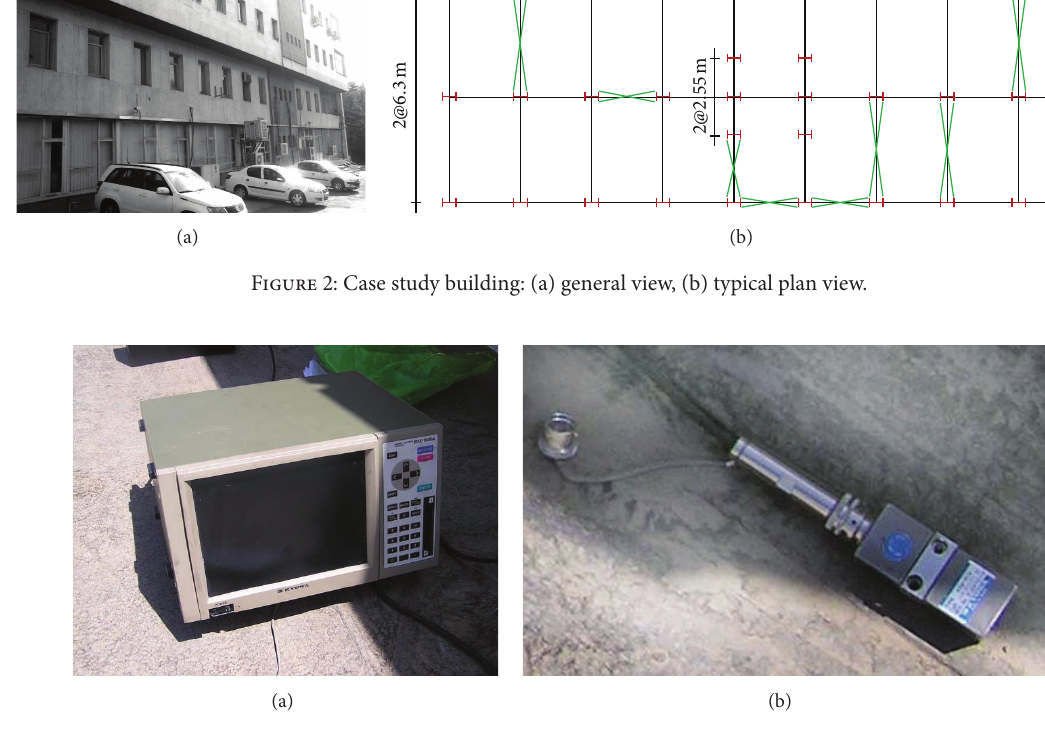
Figure 3: Instruments: (a) data logger, (b)